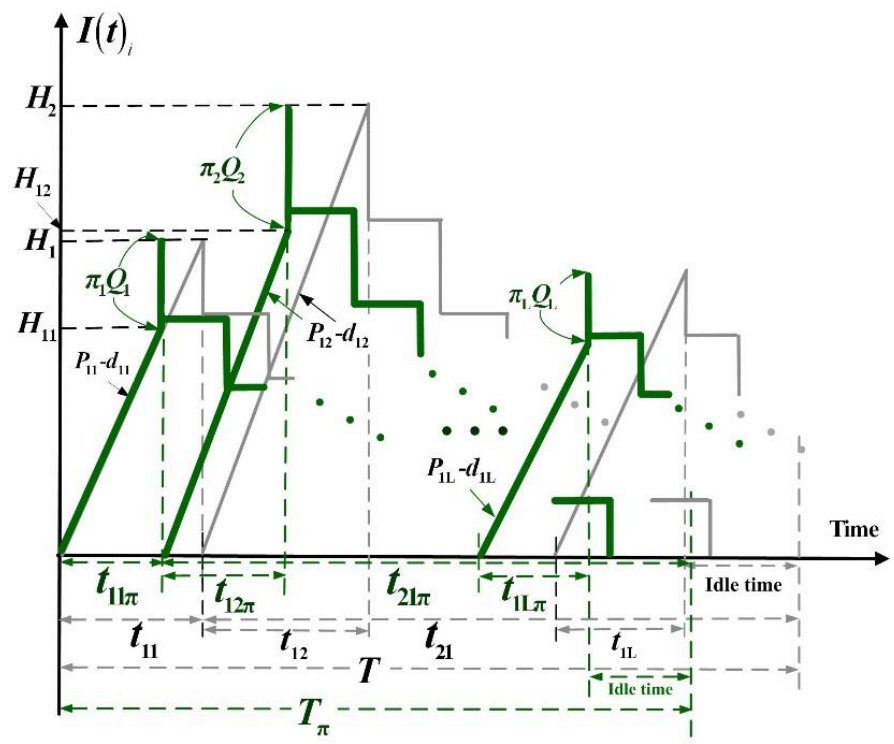
Figure 1. Inventory status of finished product i in the proposed system incorporating external source and